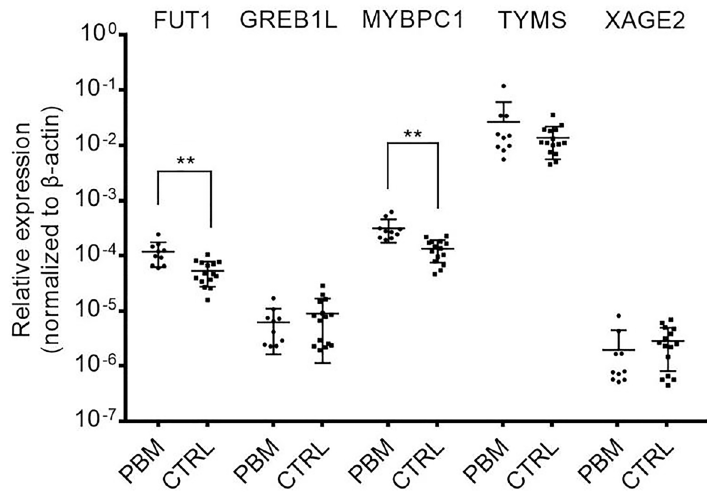
Figure 3. KEGG pathway analysis. The fi rst ten pathways that exhibited signi fi cant differences (differentially expressed (DE) genes) between the 2 groups (P o 0.005) are listed (up-regulated mRNAs). Seventeen genes known to be related to cancer were observed in pancreaticobiliary maljunction.